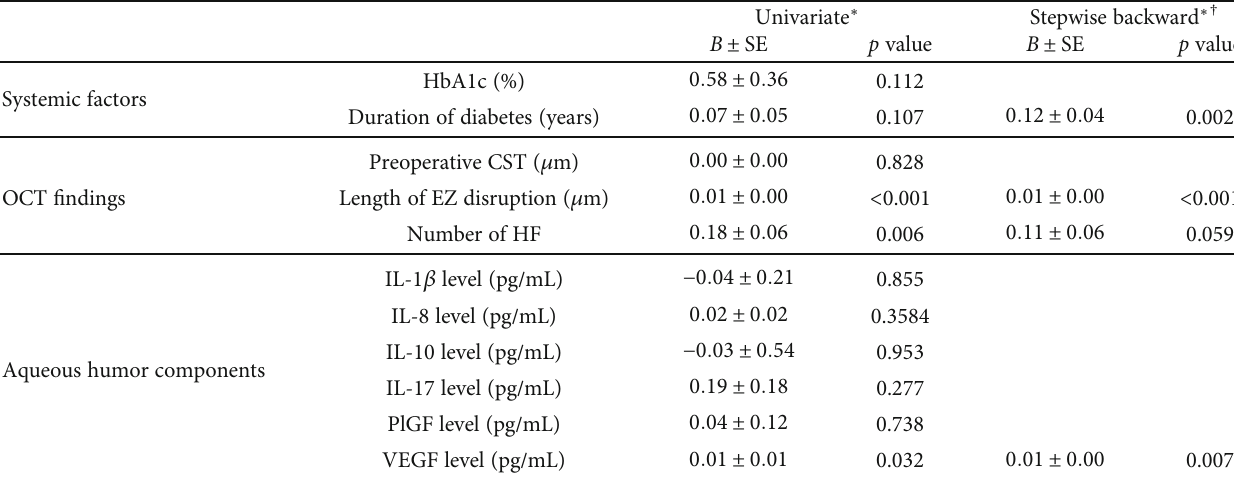
Table 2: Parameters associated with the glucose-regulated protein of 78 kDa (GRP78) levels in the aqueous humor of center-involving diabetic macular edema patients in univariate and multivariate regression